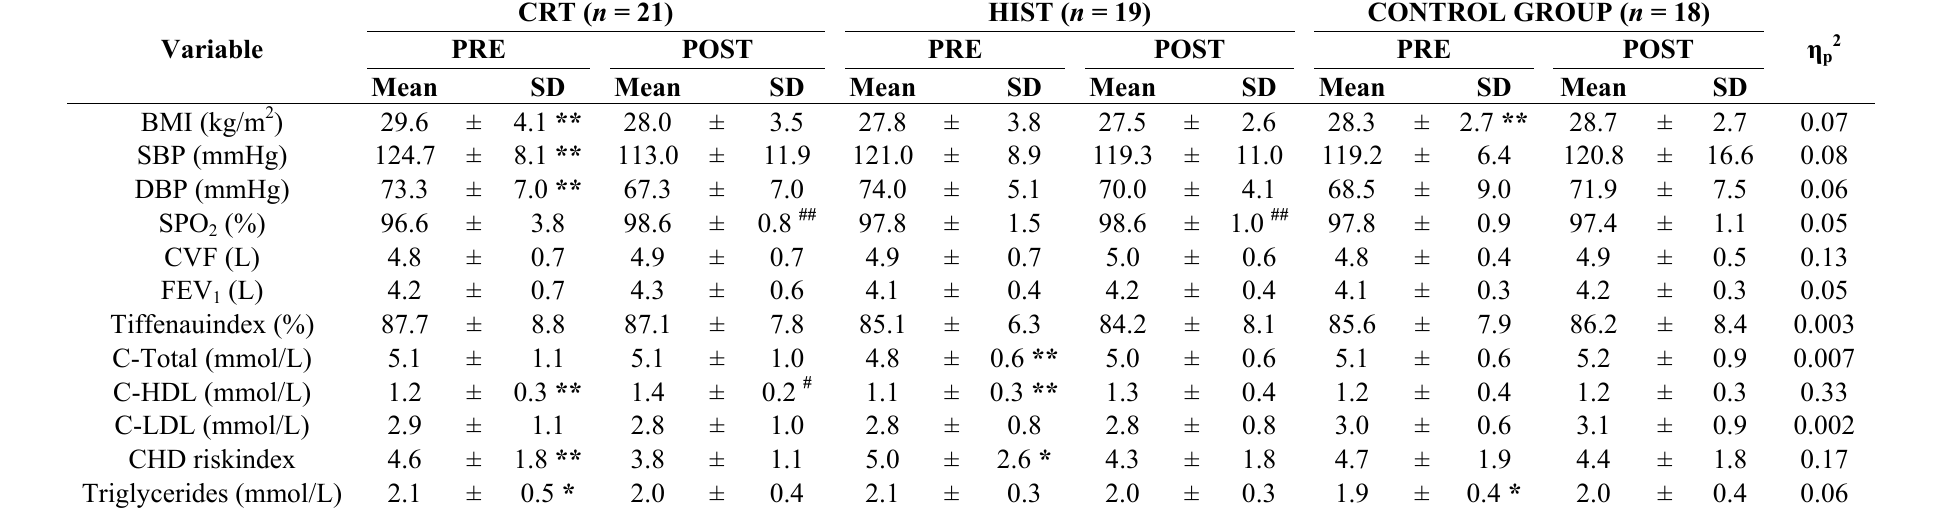
Table 2. Descriptive statistics (Mean ± SD) of health status variables.